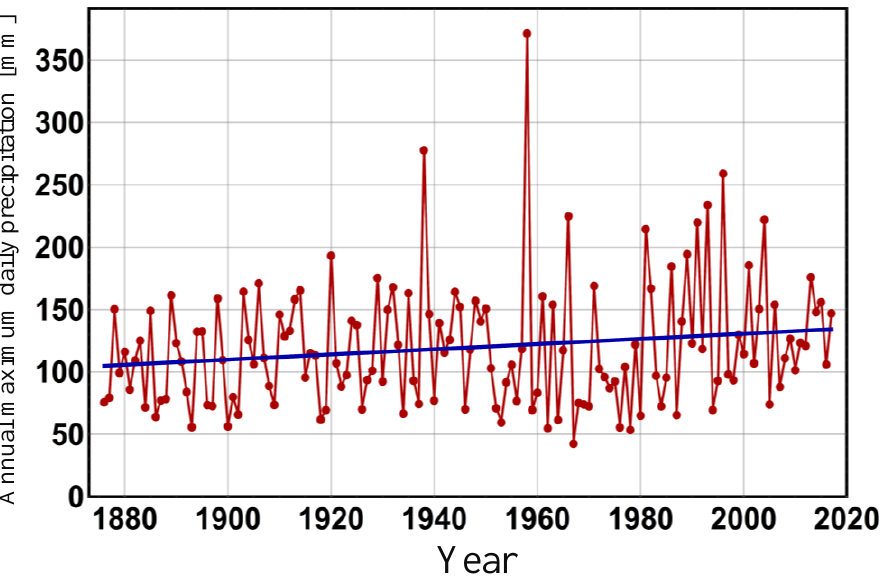
Figure 1. Time series showing observed data of the annual maximum daily precipitation over 142 years from 1876 to 2017 at the Meteorological Agency ground observation station Tokyo and the regression line fitted to this time series.